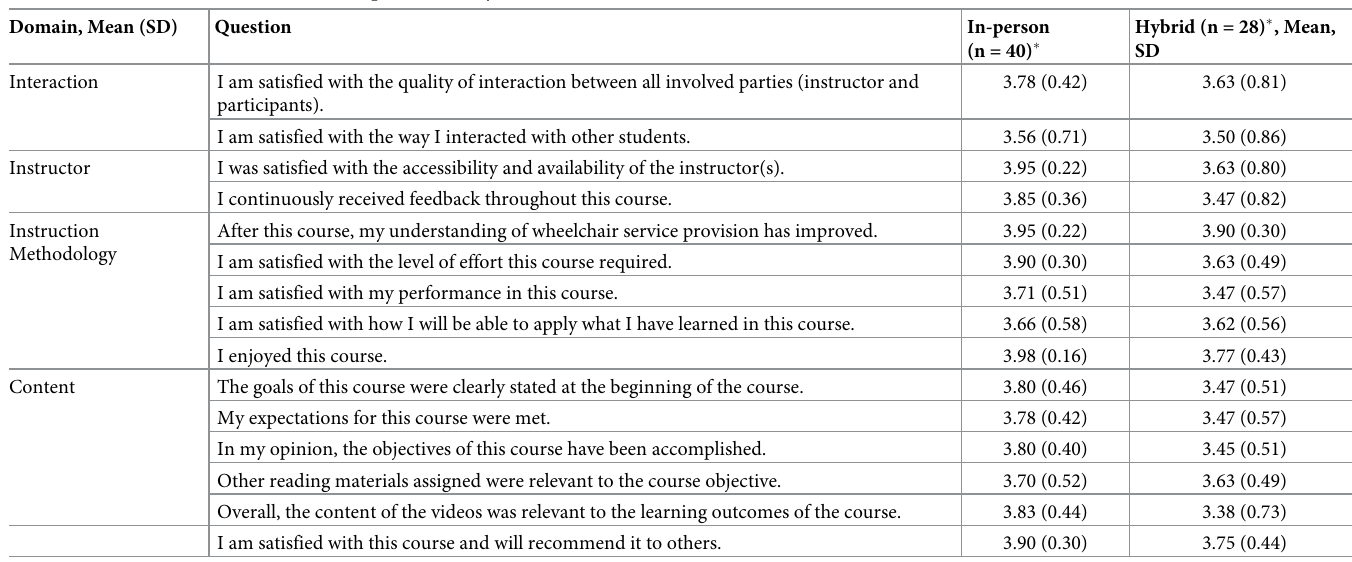
Table 8. Means and standard deviations of questions analyzed. Domain, Mean (SD)